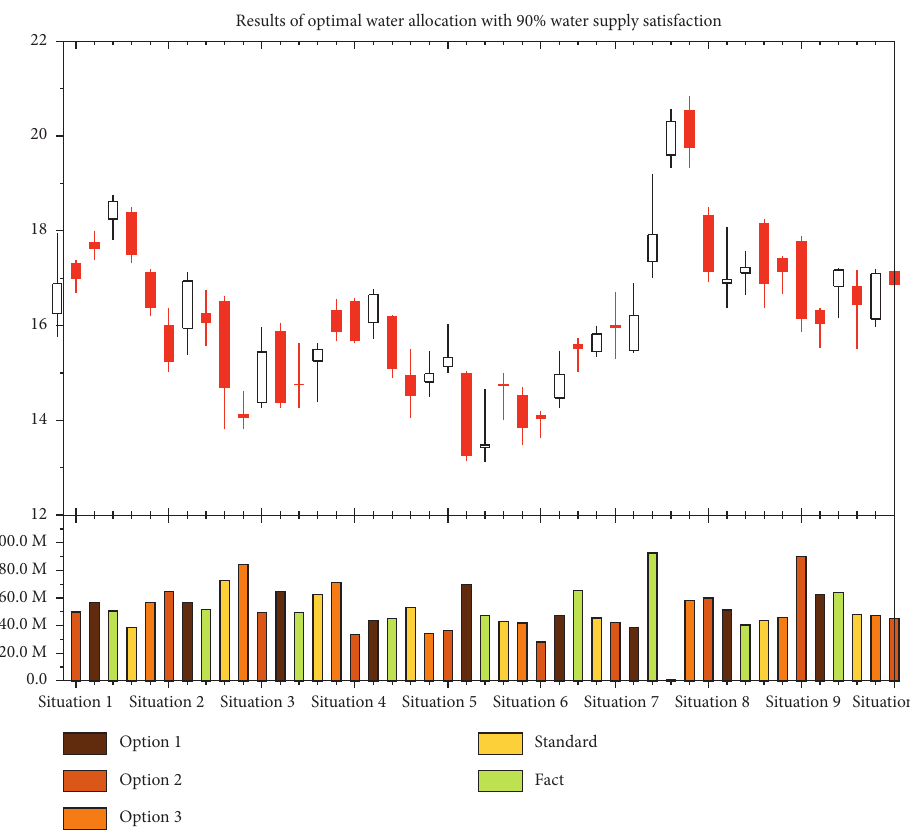
Figure 8: Results of optimal water allocation with 90% water supply